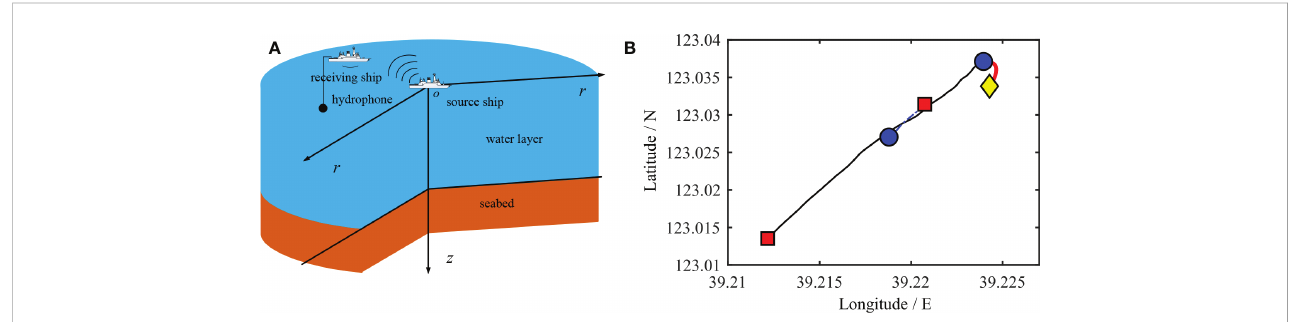
FIGURE 10 Schematic diagram of the experimental con fi guration, the deployment of the source ship and receiving ship (A) and the longitude and latitude of the distance between the two ships (B) .